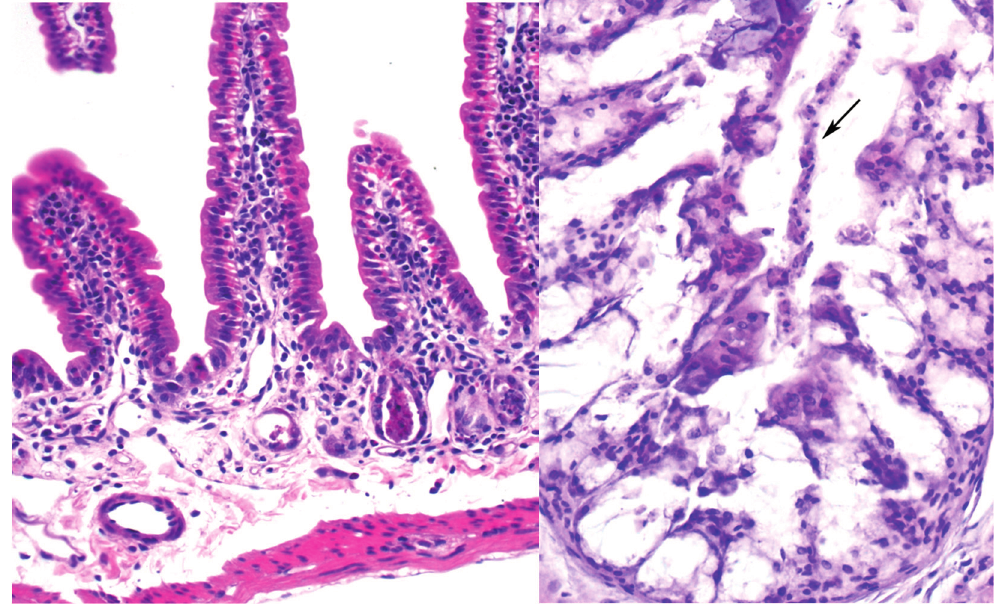
Figure 3. Effects of ebulin f on intestines. Histological sections of small ( left ) and large ( right ) intestine of mice stained with haematoxylin and eosin. (left) Severe atrophy of Lieberkühn’s crypts (arrows) is present in an animal injected with 5 mg/kg. ×235; (right) Derangement of the epithelium showing some dead cells sloughed off in the colonic lumen (arrow) can be seen in an animal injected with 2.8 mg/kg ebulin f.